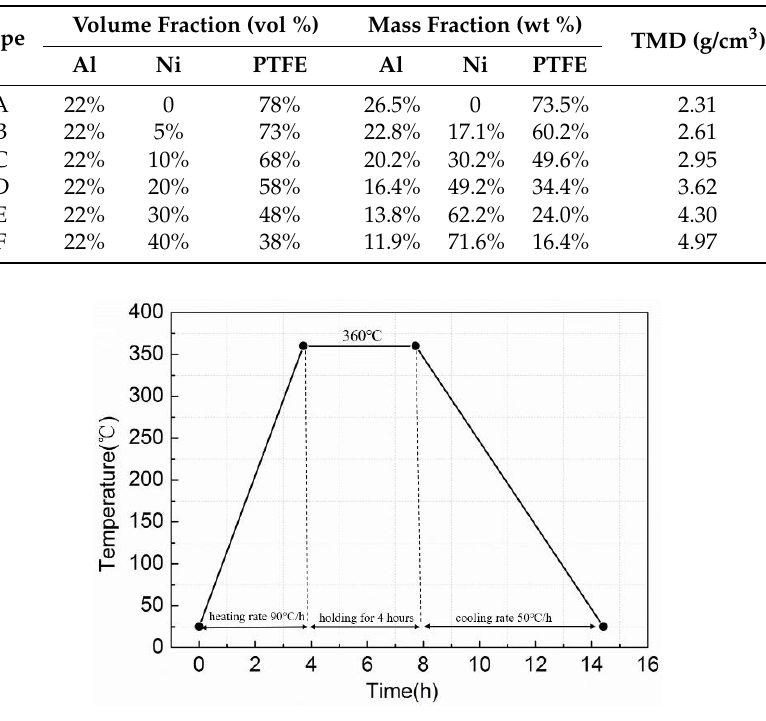
Figure 1. The temperature history of the sintering cycle.